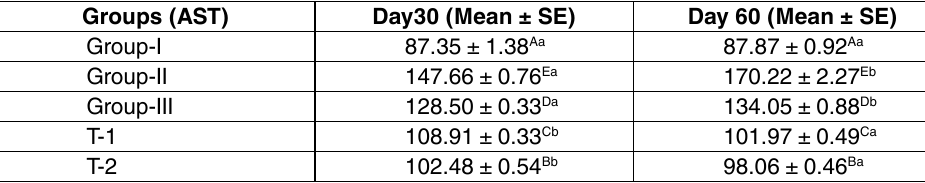
table 5. The mean ± SE AST (IU/L) values in different treatment groups. Groups (ASt)